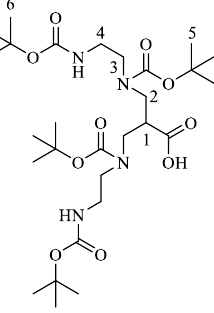
Figure 5. Characterization of ( t Bu) 4 N 4 by 1 H-NMR (400 MHz, DMSO- d 6 ) δ = 6.79 (s, 2H, NH),